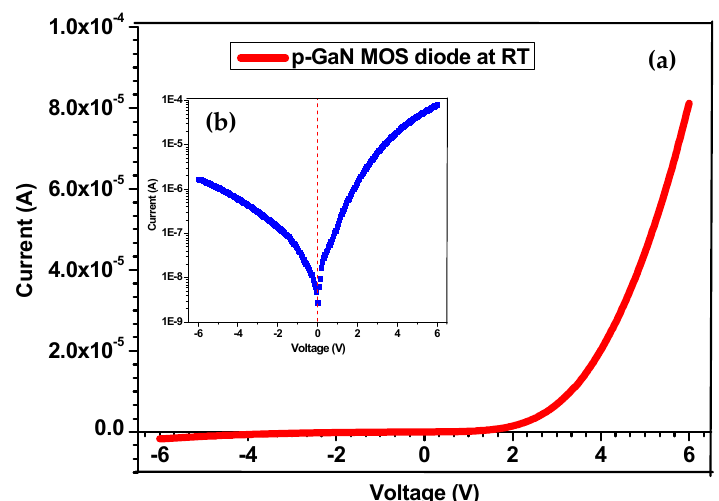
Figure 3. ( a ) I – V plot of the as-deposited Al / SiO 2 / p -GaN MOS Schottky diode tested at RT, ( b ) the forward and reverse ln I – V characteristics of diodes.